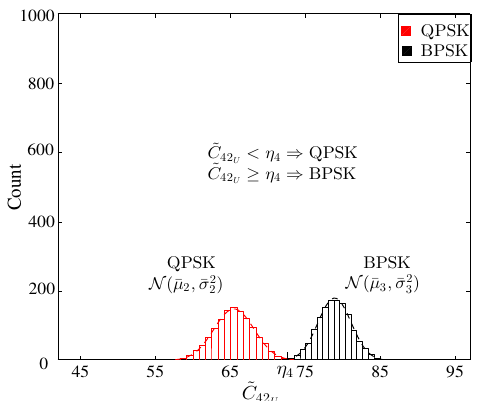
Figure 5. Histogram of ˜ C 42 for BPSK and QPSK. Adapted with permission from Ref. [63]. Copyright U 2021